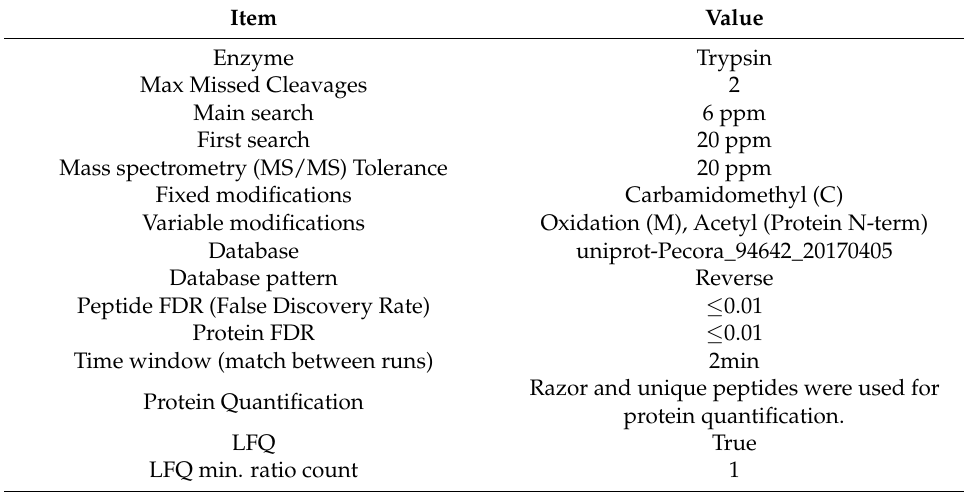
Table 3. Parameters setting in MaxQuant comparative analysis.